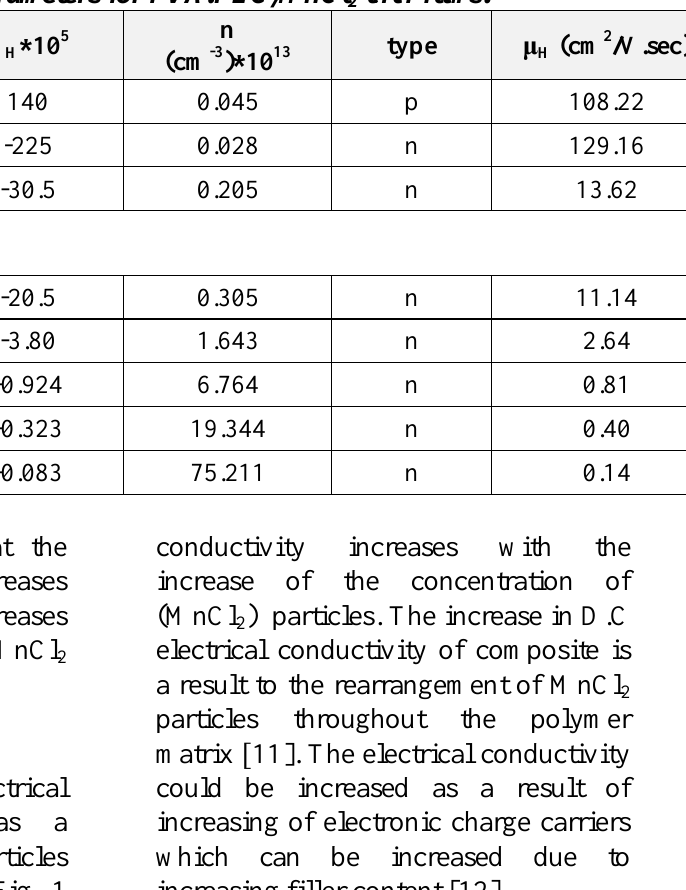
Table 1: Electrical parameters for PVA:PEG/MnCl